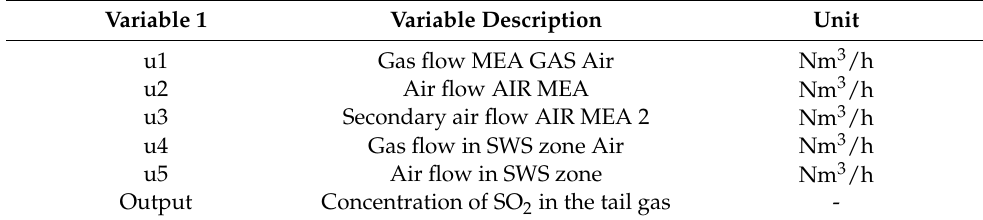
Table 3. Description of SRU process